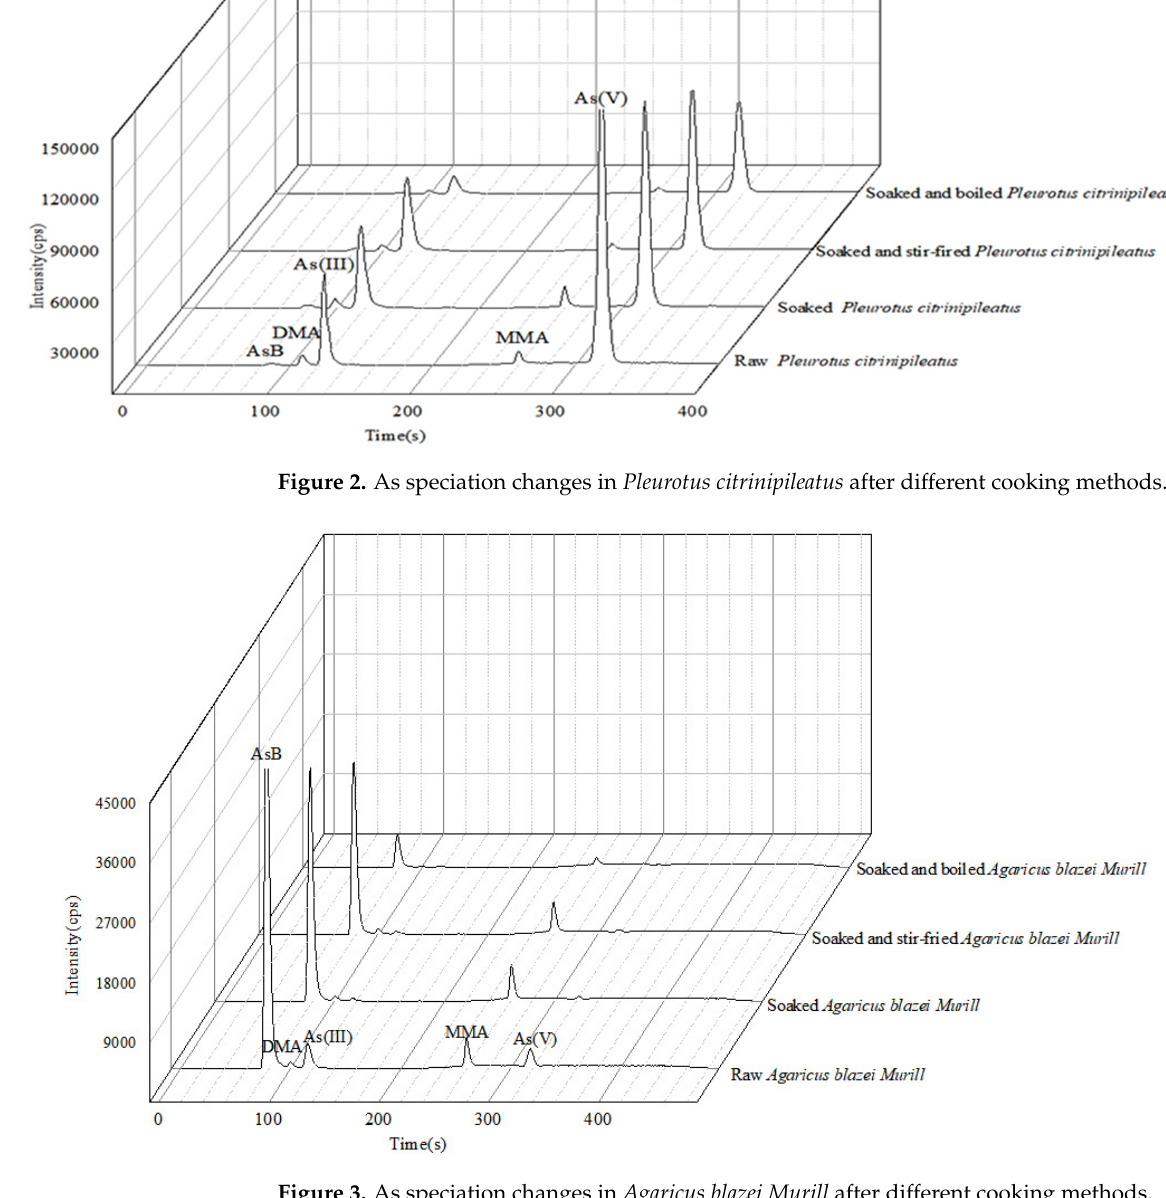
Figure 3. As speciation changes in Agaricus blazei Murill after different cooking methods.